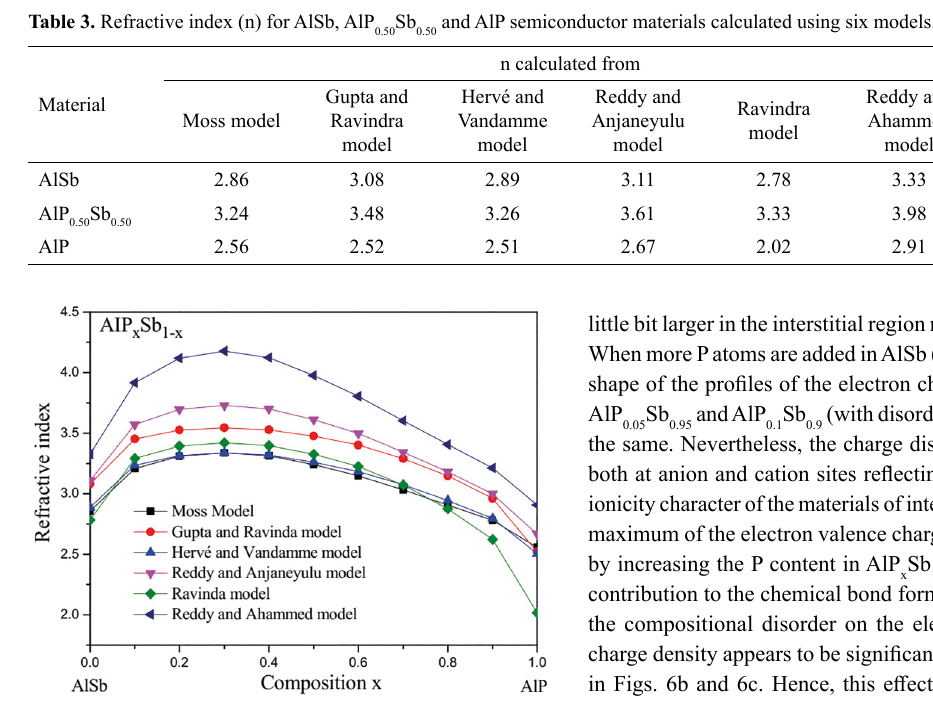
Figure 4. Refractive index in AlP content calculated using various